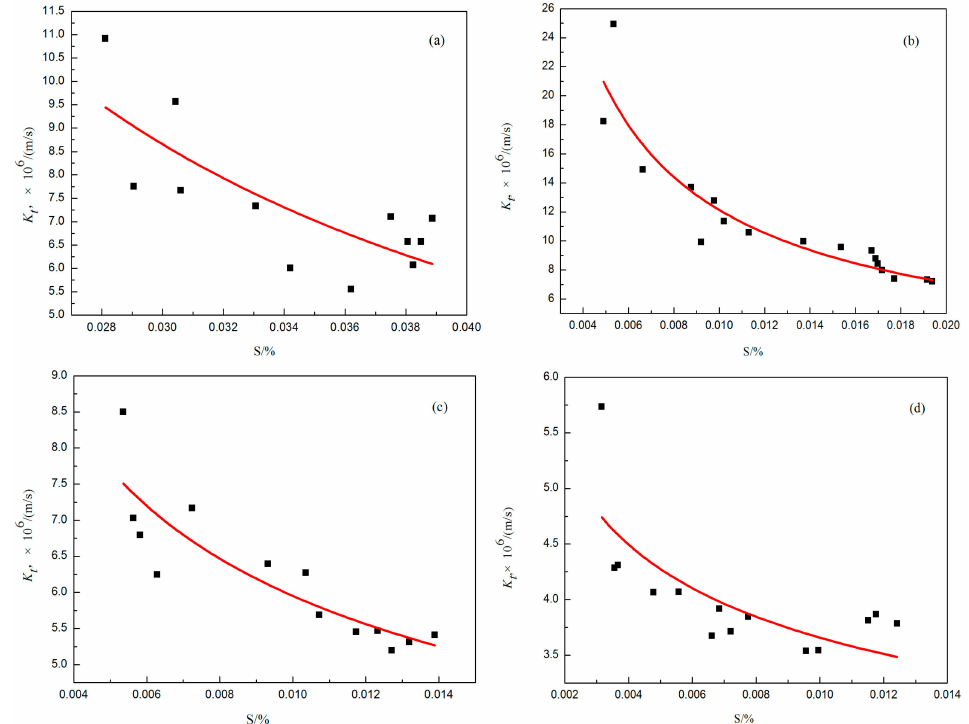
Figure 8. E ff ect of sulfur content in the iron-carbon bath on the k t of coke samples. ( a ) Coke 1 ( R = 96.22%, m ci = 7.5 g), ( b ) coke 1 ( R = 99.95%, m ci = 0 g), ( c ) coke 2 ( R = 99.95%, m ci = 0 g), ( d ) coke 3 ( R = 99.95%, m ci = 0